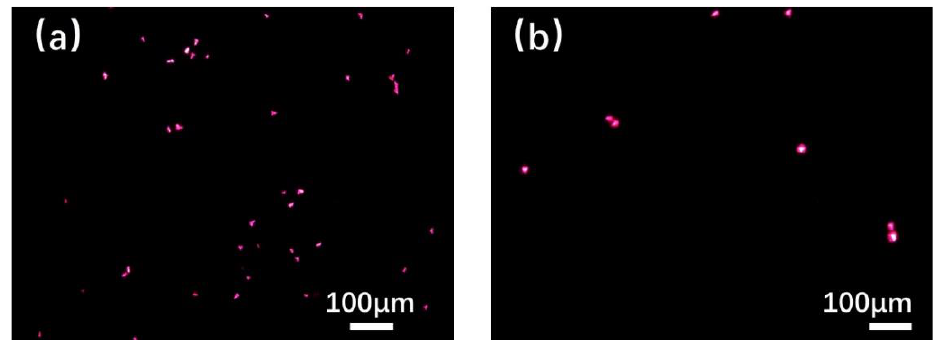
Figure 9. FM images of samples after microorganism immersion test for ( a ) PMMA sheet and ( b ) S05 coating.